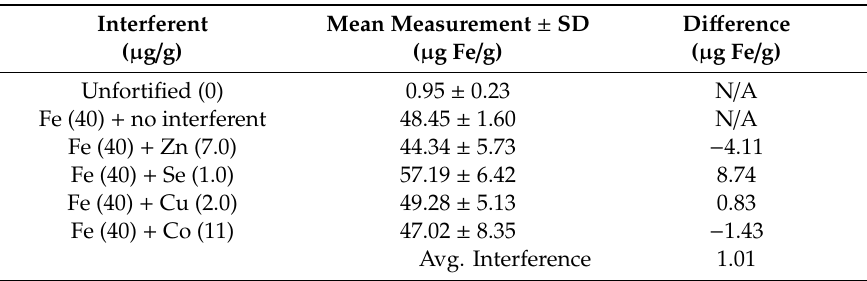
Table 1. Interference Studies.